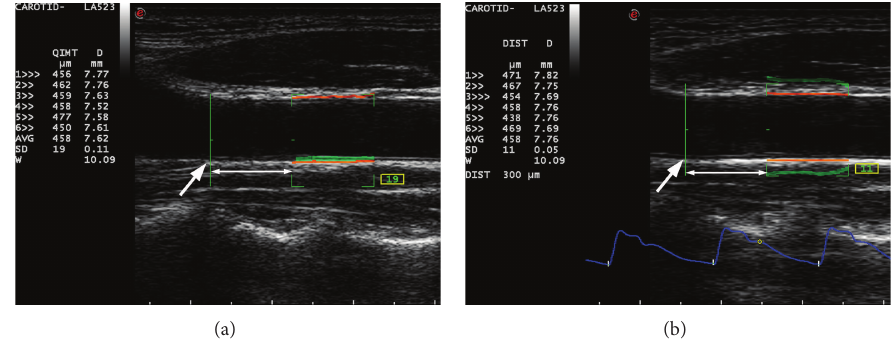
Figure 1: Measurements of the intima-media thickness and stiffness in the common carotid artery. (a) Longitudinal grey scale sonogram showing the measurement of the intima-media thickness of a common carotid artery (CCA) using radiofrequency-based quality intima- media thickness. (b) Longitudinal grey scale sonogram showing the measurement of the arterial stiffness of the same CCA using radiofrequency-based quality arterial stiffness. The arrows indicate the inferior end of the carotid bulb and the double-arrows lines show a distance of